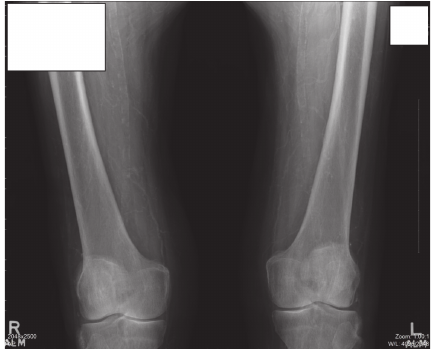
Figure 3: X-ray illustrating calcification of the femoral and popliteal